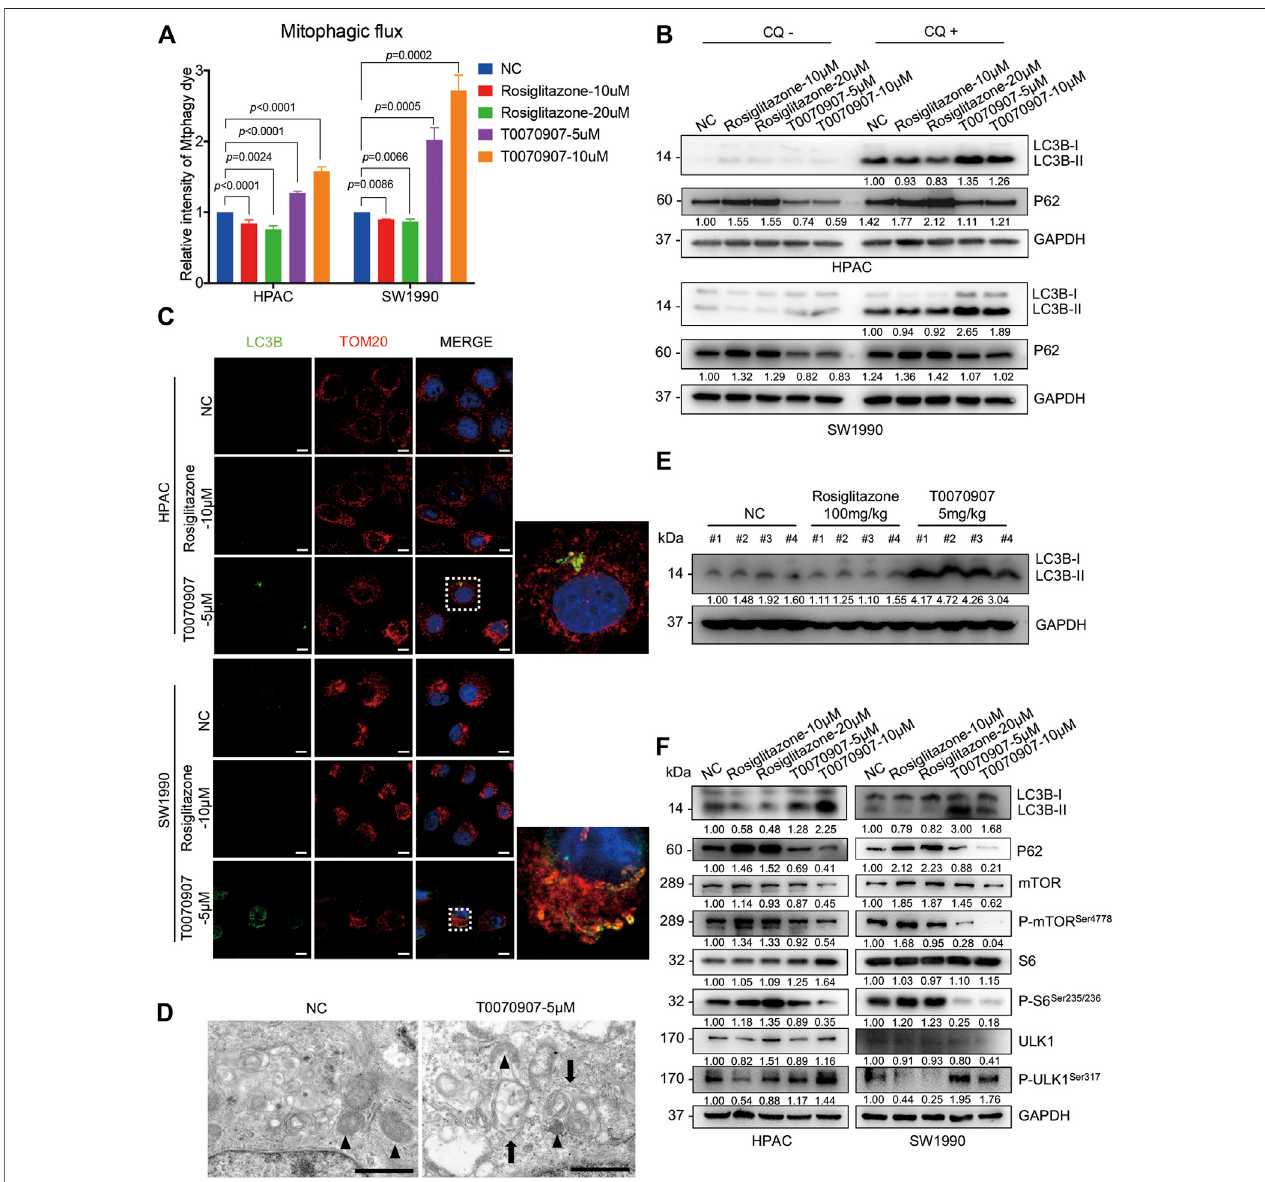
intheabsenceorpresenceautophagyinhibitor CQ(10 μ M),LC3B-II andP62wasdetectedbyWesternblottoindicatetheautophagic fl ux. (C) TheeffectsofT0070907 on mitophagy indicated by LC3B-II expression was further con fi rmed by cell Immuno fl uorescence. The scale bar was 20 μ m. (D) Representative TEM